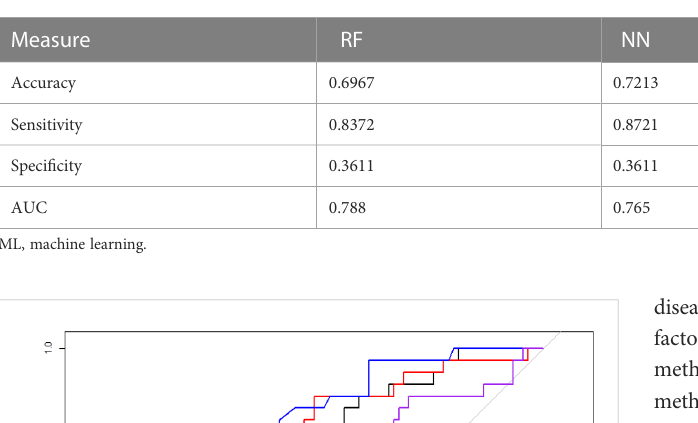
TABLE 6 Performance measures of four ML models.